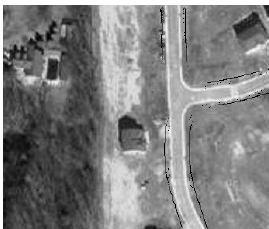
Figure 5: Detected road lines using Ribbon Snake